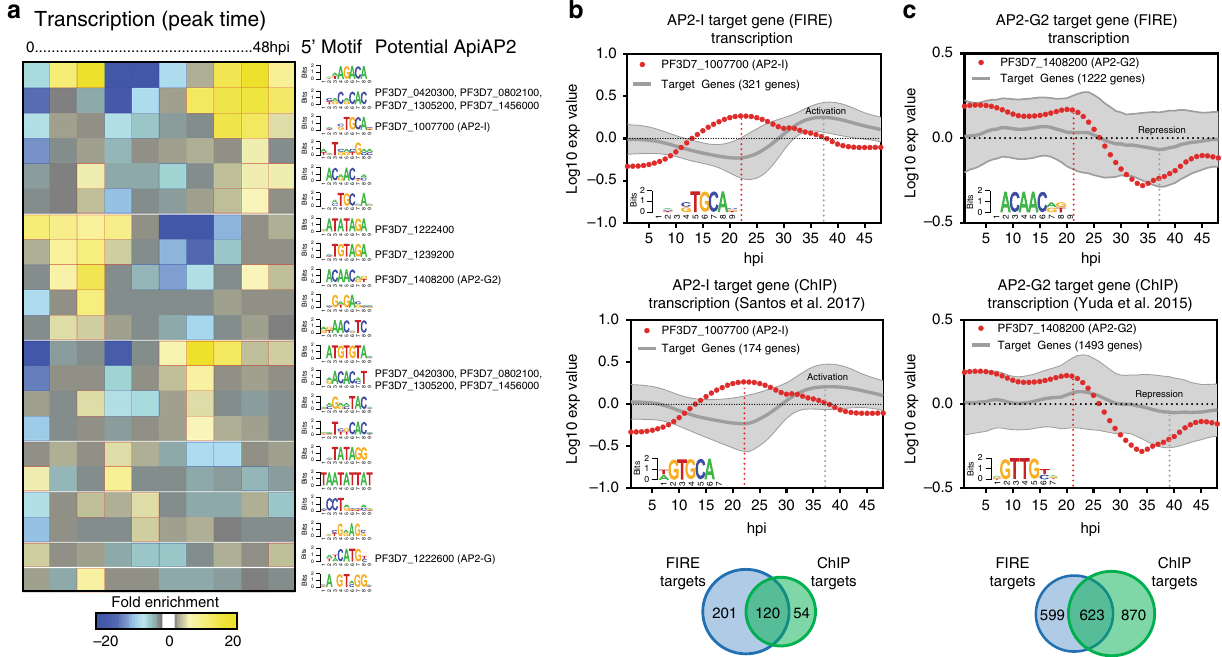
Fig. 6 Prediction of cis -regulatory motifs from P . falciparum mRNA dynamics. a FIRE analysis prediction of enriched DNA and RNA motifs within the whole genome dynamics data. The pro fi les of transcription and stabilization are clustered into peak timing during the IDC (columns) predicted enriched motifs arranged into putative functional modules (rows). The yellow color map indicates overrepresentation of a motif in a given cluster; signi fi cant overrepresentation ( p < 0.05 after Bonferroni correction) is highlighted with red frames. Similarly, the blue color map and blue frames indicate underrepresentation. For each motif, the ApiAP2 trans -factor demonstrated to interact with each predicted motif 70 is listed. b The nascent transcription pro fi le of genes identi fi ed by FIRE (left panel) or ChIP-seq (right panel 71 ) with the enriched Pf AP2-I motif GTGCA are plotted (gray, mean log 2 expression value and ±s.e.m.) in comparison to the transcription pro fi le of pfap2-i (red circle). Venn Diagram represents the overlap of genes identi fi ed by FIRE (blue) or ChIP-seq (green). c The nascent transcription pro fi le of genes identi fi ed by FIRE (left panel) or ChIP-seq (right panel 72 ) with the enriched Pf AP2-G2 motif ACAAC are plotted (gray, mean log 2 expression value and ± s.e.m.) in comparison to the transcription pro fi le of pfap2-g2 (red). Venn Diagram represents the overlap of genes identi fi ed by FIRE (blue) or ChIP-seq